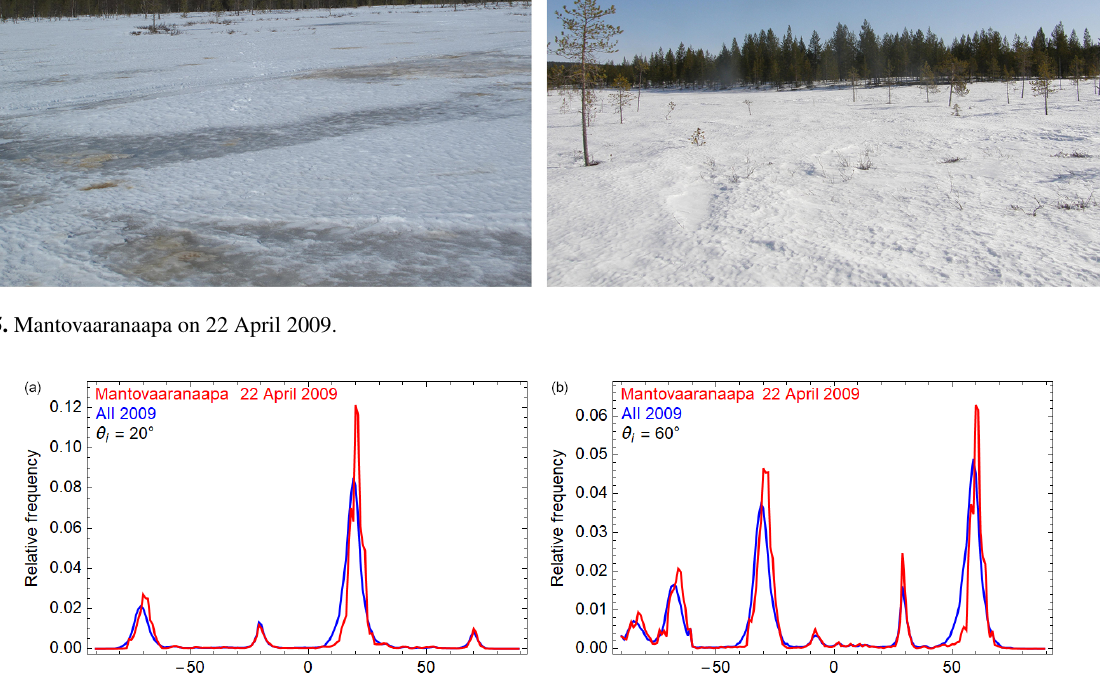
Figure 16. Calculated average scattering angle distributions for surface scattering (i.e. zenith angles of reflected radiation, positive for forward directions and negative for backward directions) for profiles measured during the SNORTEX campaign in 2009 (blue) and in Mantovaaranaapa on 22 April 2009 (red) for incidence angle values 20 and 60 ◦